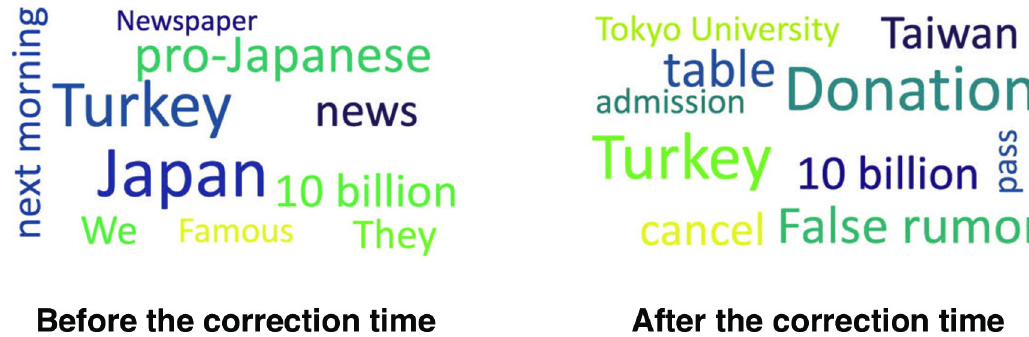
Fig 6. Example of word cloud before (left) and after (right) the correction time t words in the fake news story (Turkey in the Tohoku